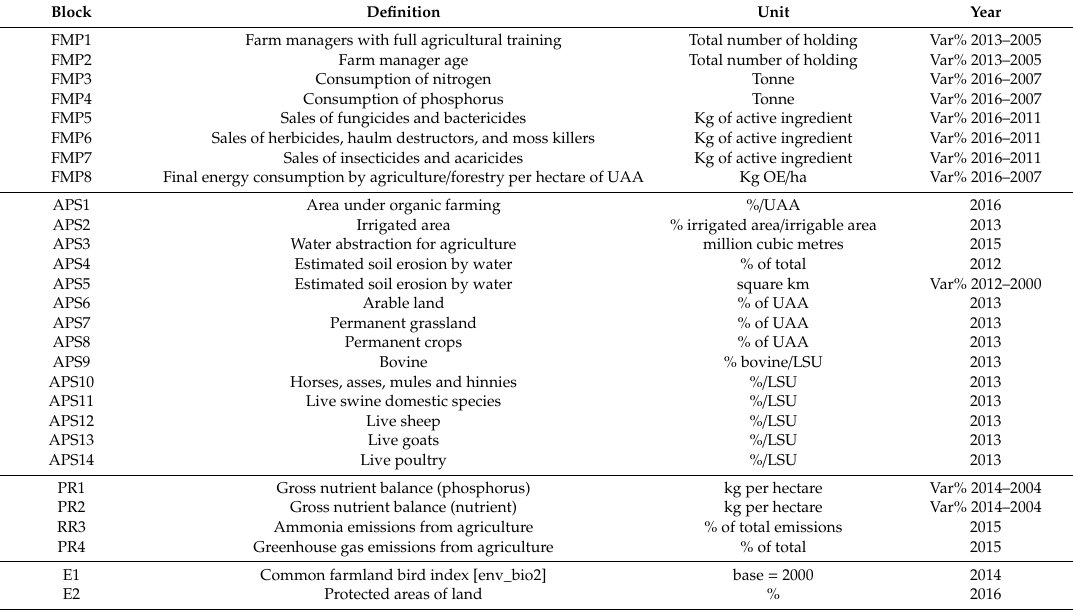
Figure 1. The four blocks of agri-environmental indicators considered. Source: Author’s processing of information from the EUROSTAT (Statistical Office of the European Communities) database. Table 1. List of starting agri-environmental indicators (AEIs) included in this research.